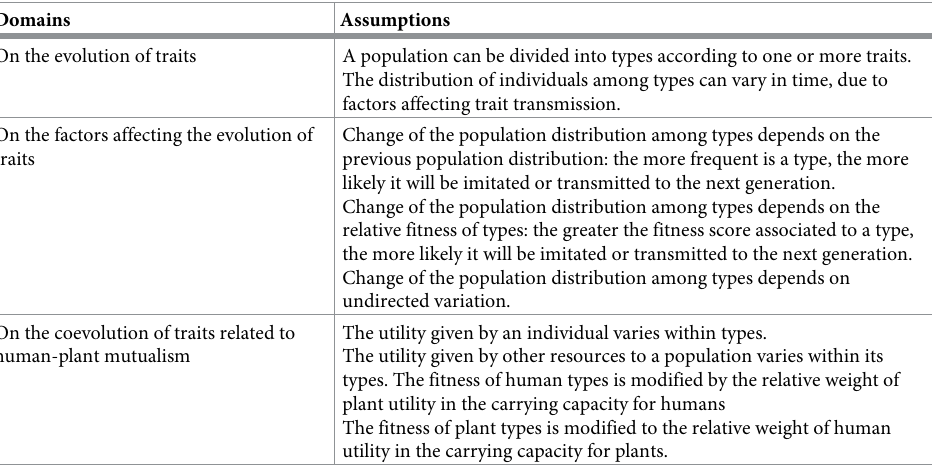
Table 5. Assumptions on population diversity and